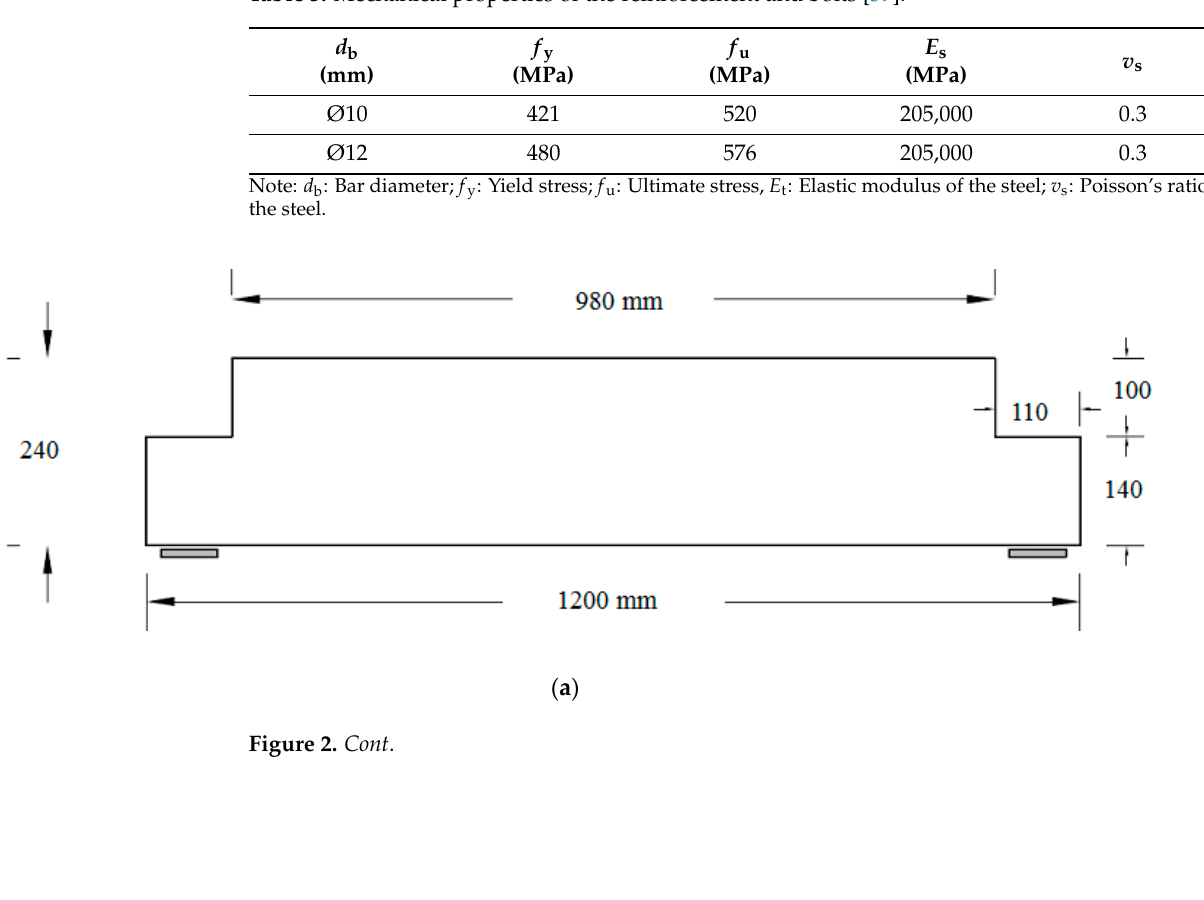
Table 3. Mechanical properties of the reinforcement and bolts [39].